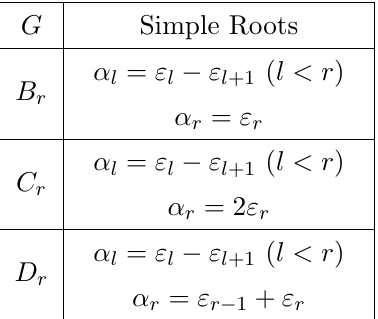
Table 1 . Simple Roots for Lie algebras of type B , C and D of rank r expressed in an orthonormal basis ( " 1 ; : : : ; " r ) of R r .